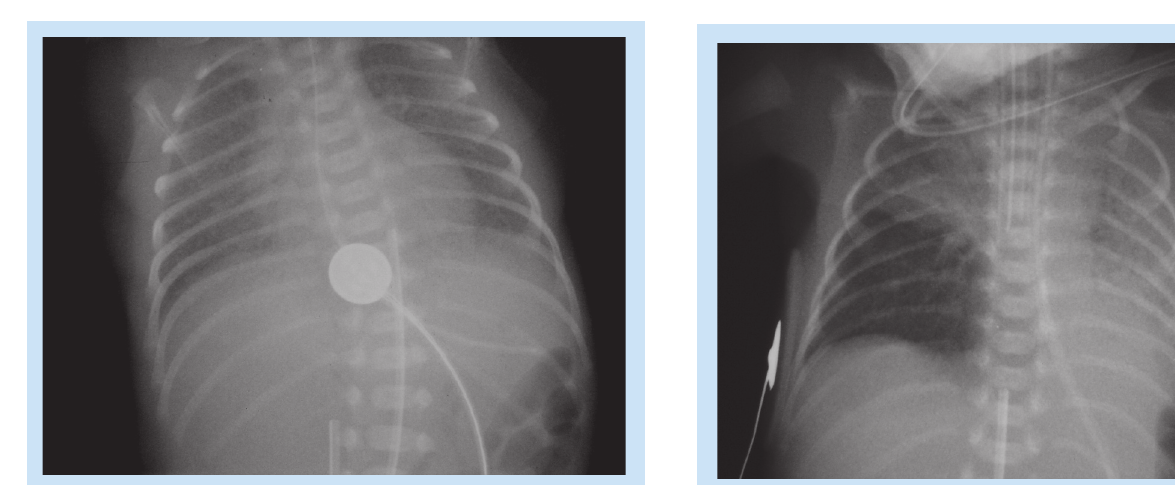
Fig. 8. Poor line positioning. The umbilical vein catheter has its tip near the renal veins, which is undesirable. The umbilical artery catheter is positioned above the renal arteries.